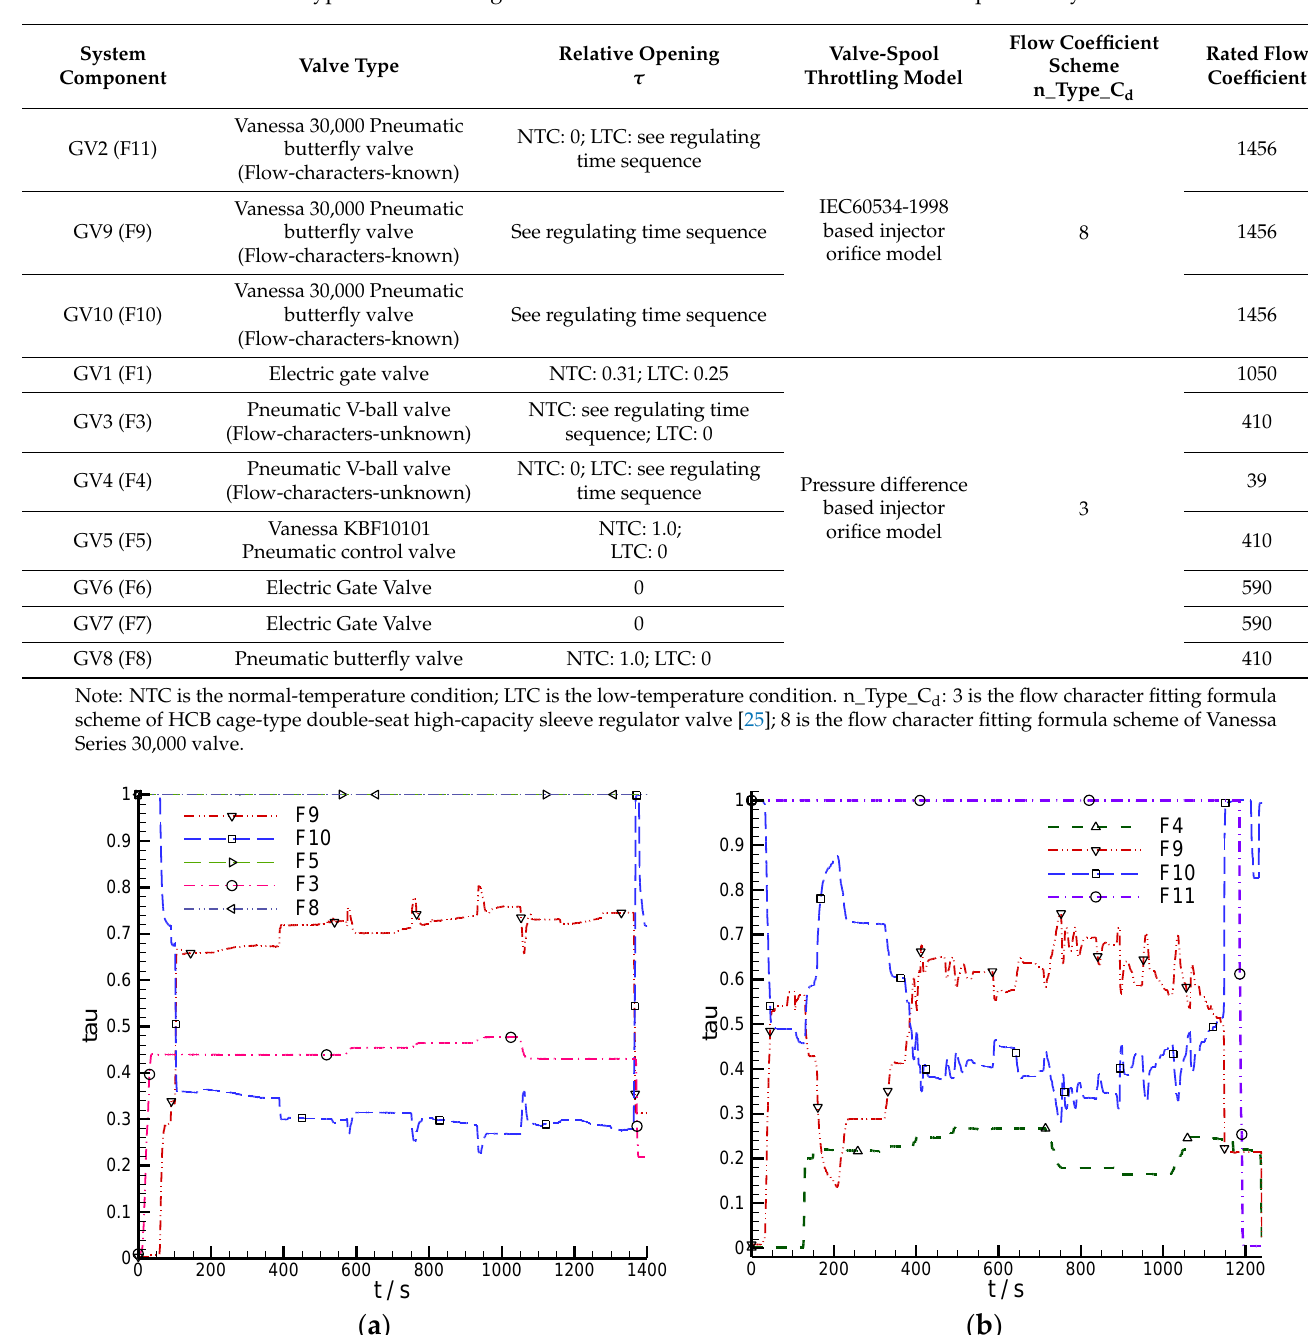
Table 2. Types and throttling calculation schemes of ten valves in the 47-components system.